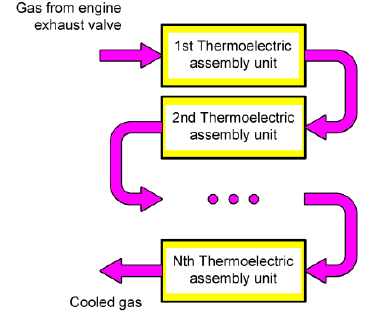
Fig. 3. General configuration of exhaust heat recovery